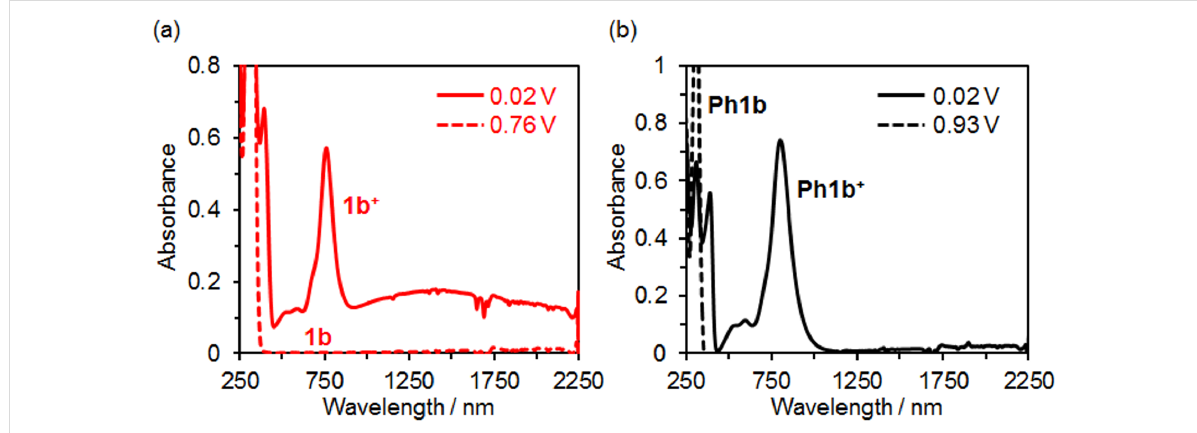
Figure 4: UV–vis-NIR spectral changes of CH 2 Cl 2 / n -Bu 4 NPF 6 (0.10 M) solutions containing (a) 1b (4.5 × 10 − 4 M) and (b) Ph1b (5.0 × 10 − 4 M) during the controlled potential electrolysis. Potentials in mV vs. Fc* + /Fc*.